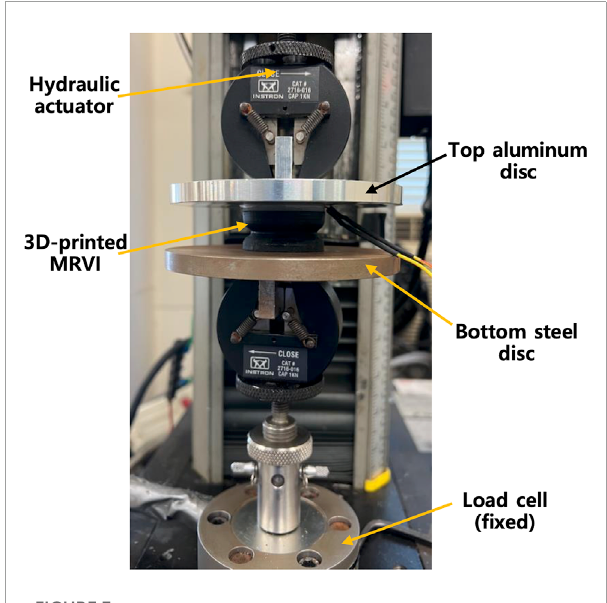
FIGURE 3 Experimental setup for the damper force measurement of the 3D-printed MRVI (the bottom steel disc configuration